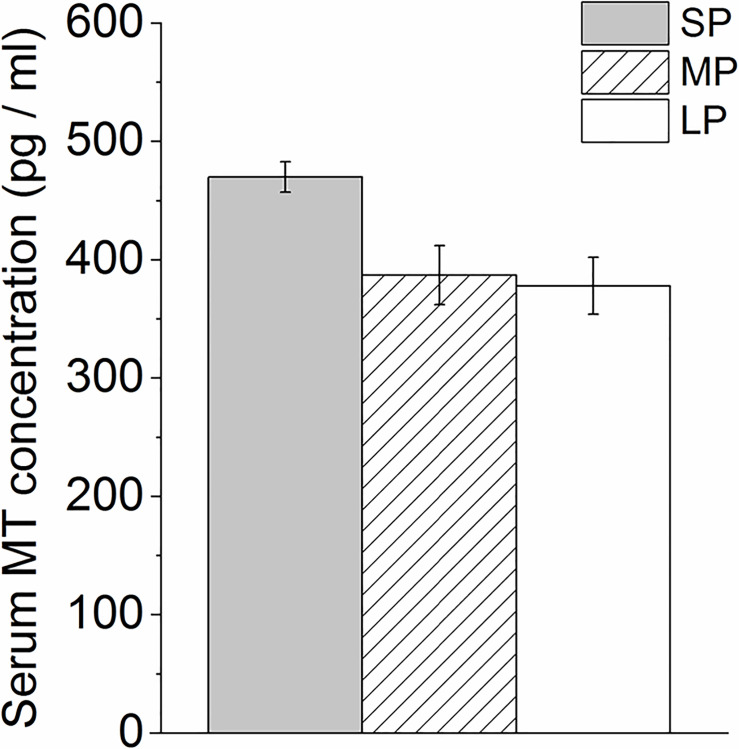
Hormones of MT in hamsters under three photoperiod groups.SP, short photoperiod; MP, moderate photoperiod; LP, long photoperiod.